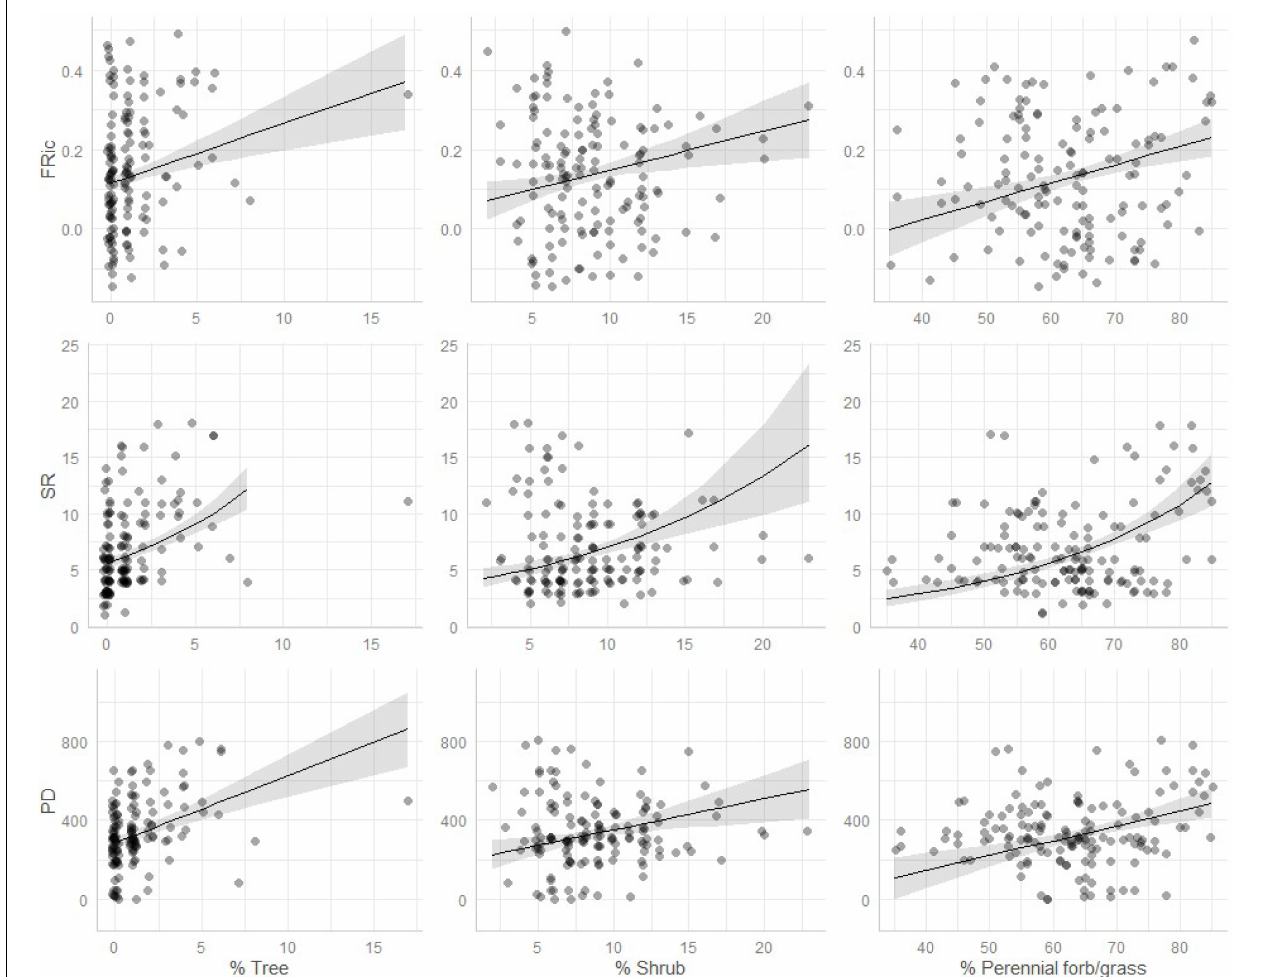
FIGURE 4 | Marginal relationships between three components of remotely sensed vegetative cover and three metrics riparian bird community diversity; functional richness (FRic), species richness (SR), and Faith’s phylogenetic diversity (PD). Dots represent individual samples, lines and shading represent predicted relationships and associated 95% confidence intervals. All three vegetative components shown here are increasing in percent cover most rapidly in areas grazed by bison and areas with no grazers. Vegetation cover data are estimated from the RAP